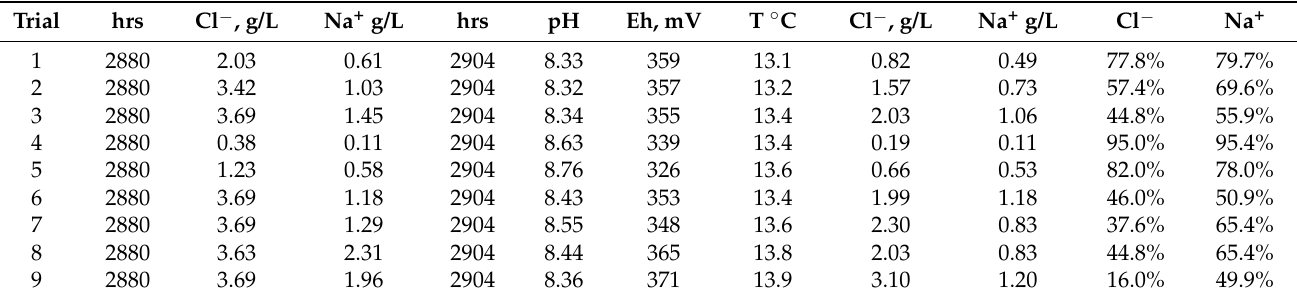
Table A7. Impact of dilution with fresh water on the stored water described in Table A6. Dilution is 1- part stored water + 5-parts fresh water. Product water analyses made 24 h after dilution. Percentages indicate the total ion removal, relative to diluted seawater.